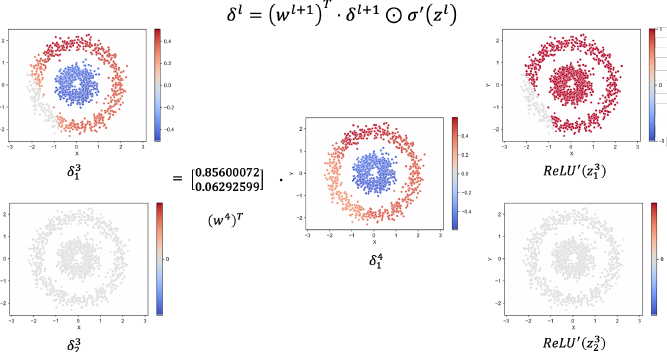
Figure 2. Backpropagation Equation (2): the visualized factors are listed below each sub-graph. Each point means a sample, and the color represents their value. Red dots are positive, blue dots are negative, and gray dots are 0. It can be seen intuitively that because some points of ReLU (cid:48) ( z 3 part of δ 3 becomes 0 through the Hadamard product. Some “errors” in δ 4 1 addition, node a 3 is the true dummy node. It completely hinders δ 4 2